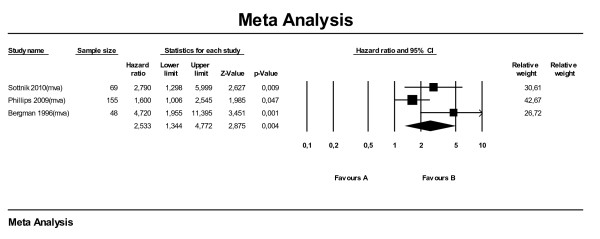
Meta-analysis of multivariate data sets for predictive value of location of tumor (LOC) on median disease free interval using hazard ratios.